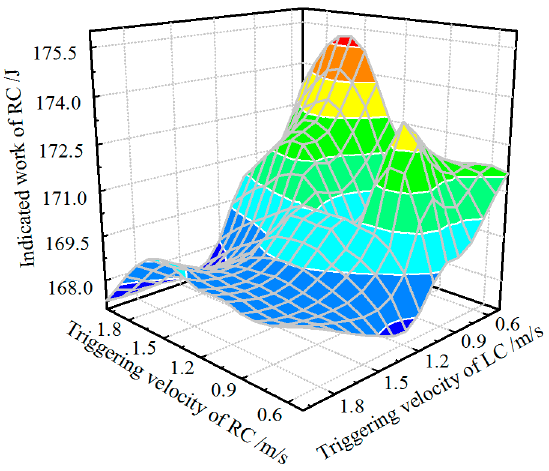
Figure 14. Indicated work map of the RC for different values of the “triggering velocity” (simulation).